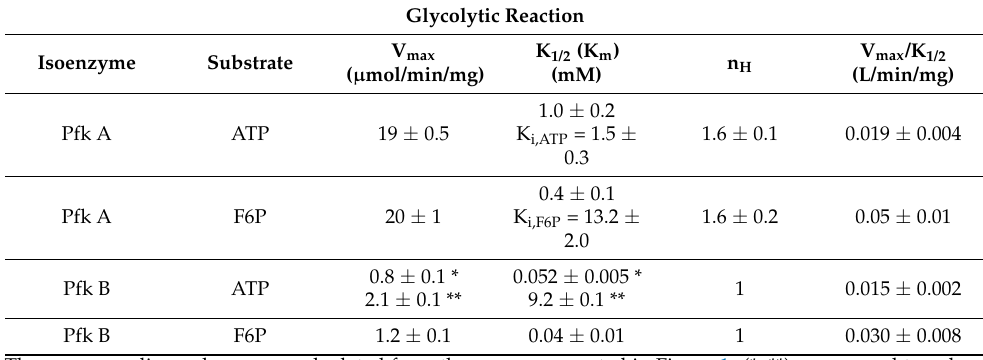
Table 1. Kinetic characteristics of Pfk A and Pfk B in the glycolytic